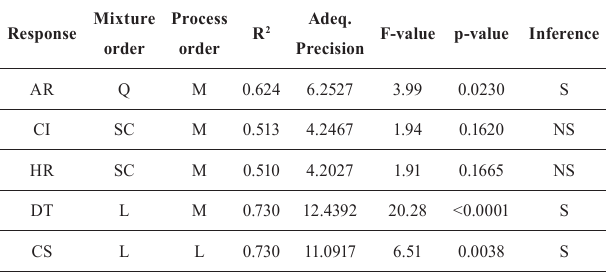
TABLE V - M odel Summary